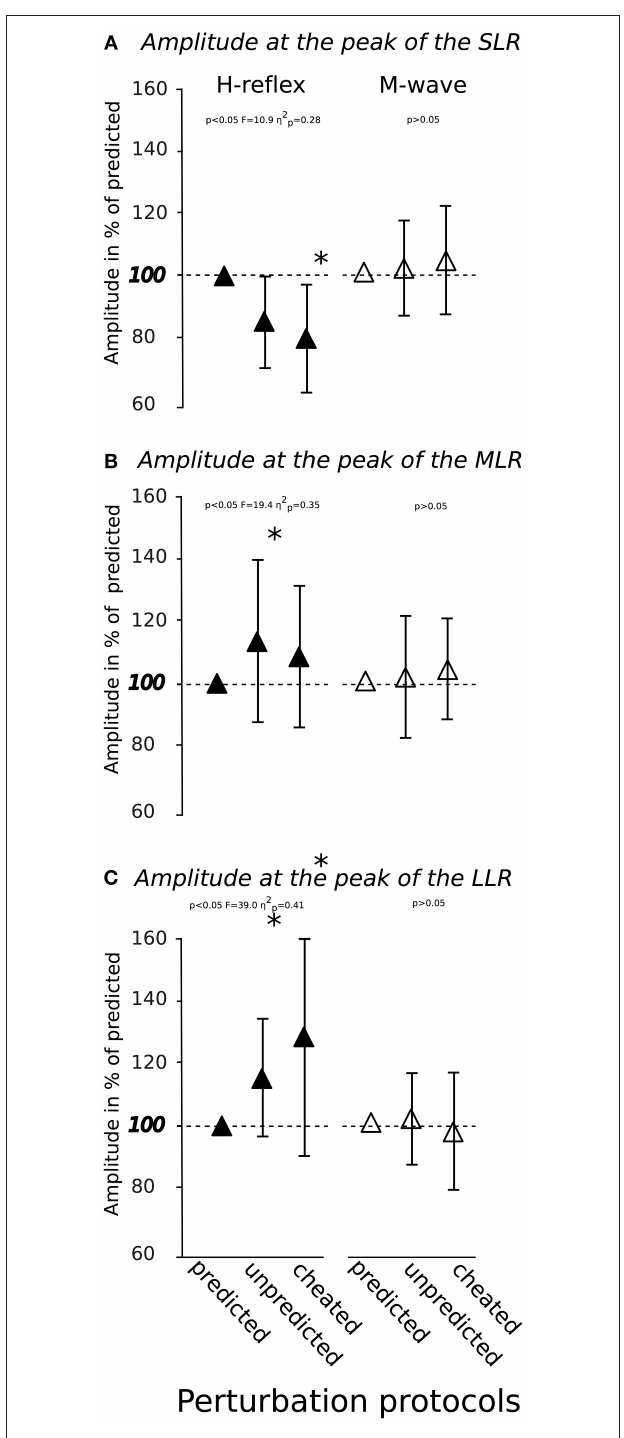
FIGURE 4 | Modulation of soleus H-reflexes ( N left) and M-waves ( 1 right) in response to predicted, unpredicted and cheated perturbations (x-axis) provoked at the peak of the short- (A) , medium- (B) , and long-latency response (C) . The horizontal dashed red line marks the initial value recorded in the control condition of predicted perturbations.*indicates significant differences compared to the control